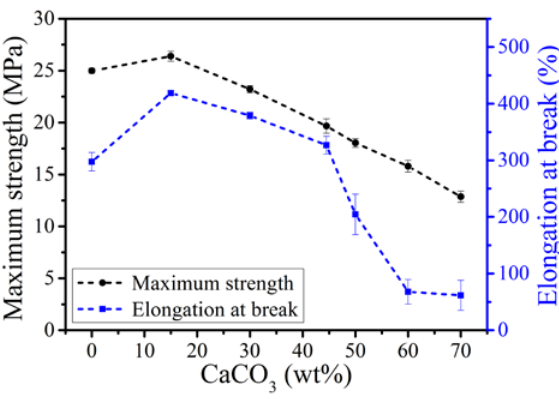
Figure A2. Typical ( a ) tensile and ( b ) bending stress-strain curves of different contents PP/CaCO 3 composites.